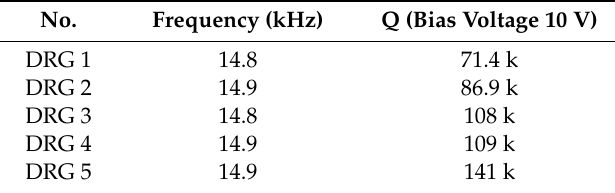
Table 5. Frequency and Q of the fabricated DRGs.